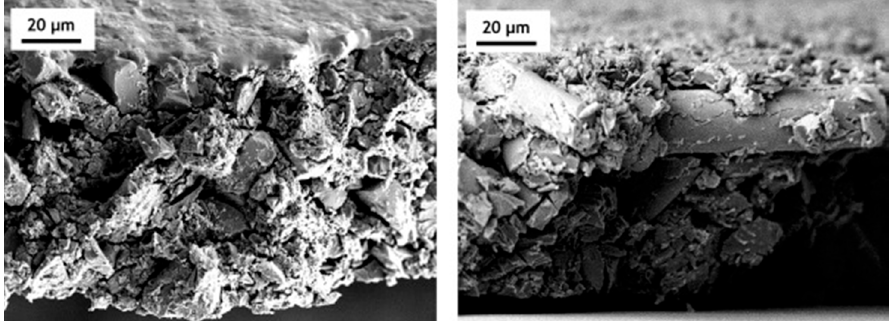
Figure 24. SEM images of cross-section of PAC-based ( left ) and ACF-based ( right ) working electrodes. Adapted from [179].